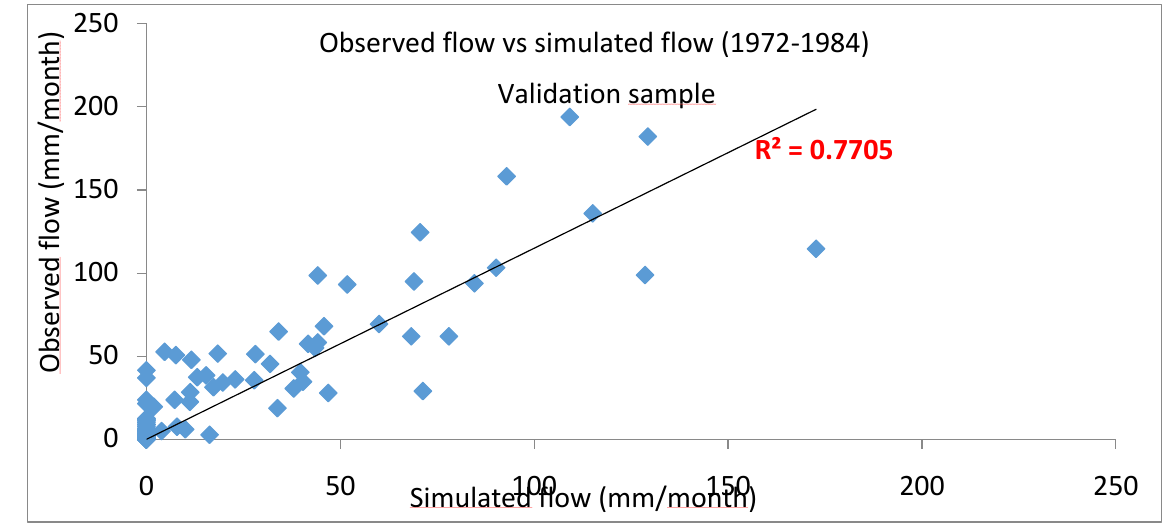
Figure 3. Scatter plot of observed and predicted monthly runoff for validation